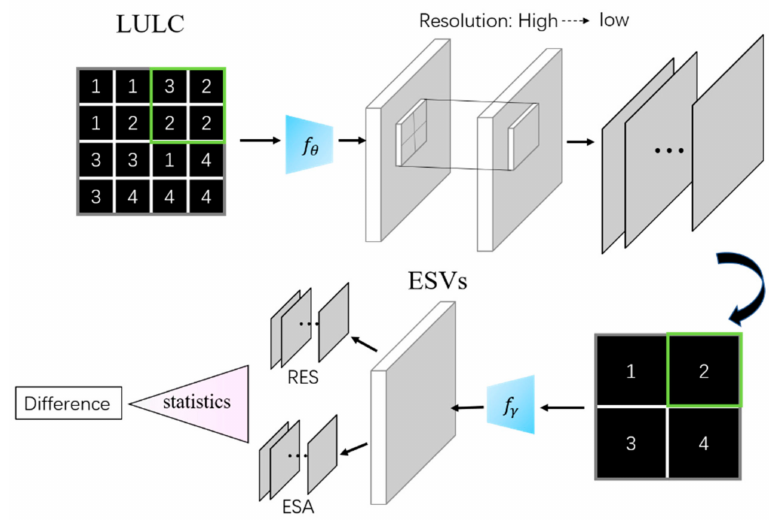
Figure 2. Acquisition of the difference in ESVs of LULC at different